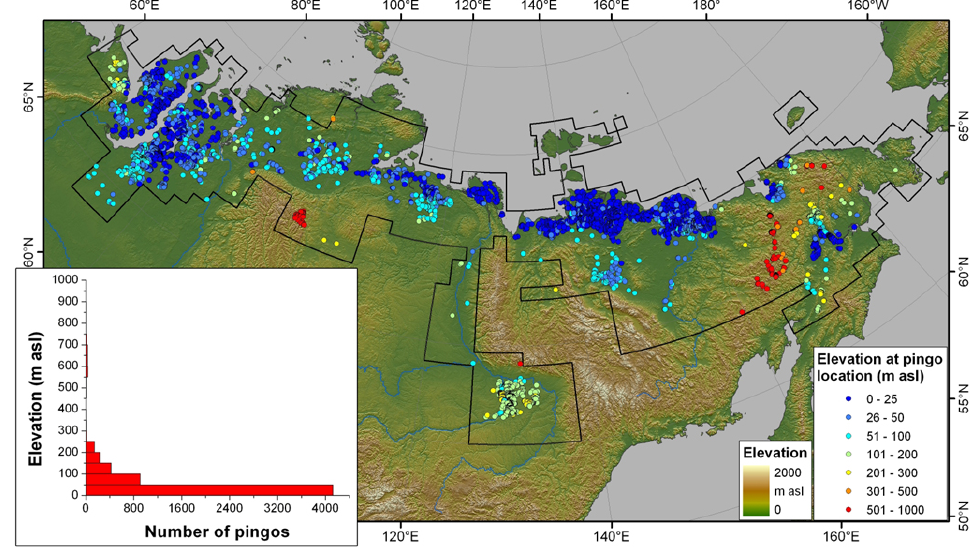
Fig. 7. Elevation of pingo locations above sea level derived from GLOBE global 1km DEM (Globe Task Team, 1999). Though the vast majority of pingos occurs in lowlands below 50m, some pingos occur in up to 1000m elevation in some mountain valleys.